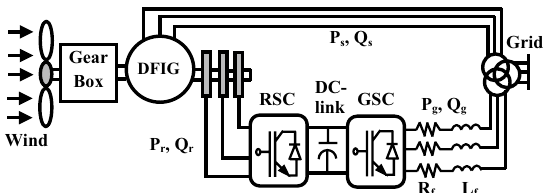
Fig. 3 Block diagram of the wind generation system using a DFIG